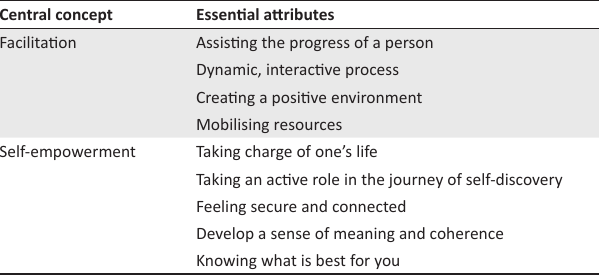
TABLE 1: The essential attributes of the concept ‘facilitation of